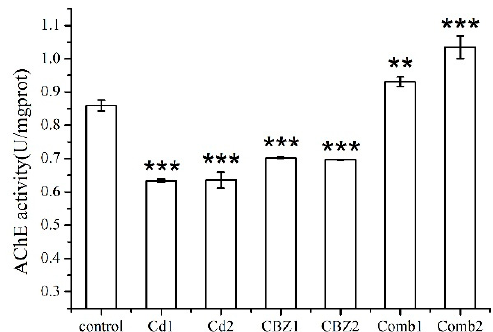
Figure 2. Acetylcholinesterase (AChE) activity in female fish after ten days of exposure to Cd, CBZ, and Cd + CBZ. The results of one-way ANOVA are indicated at the significance levels * p < 0.05, ** p < 0.01, and *** p < 0.001.